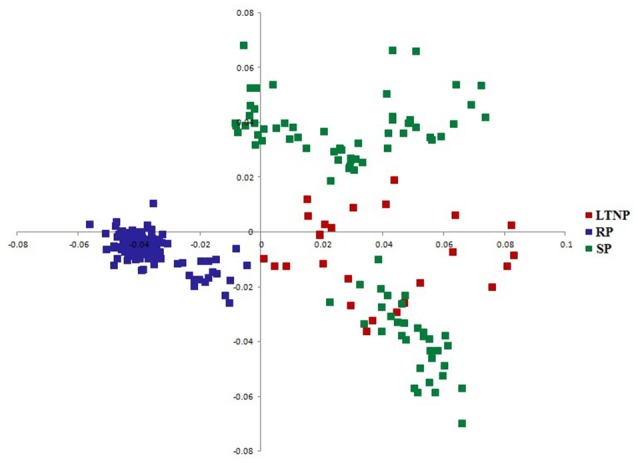
Distribution of env genes along the two major axes of correspondence analysis (COA) based on RAAU data. x-axis- Axis 1 of RAAU; y-axis- Axis 2 of RAAU. Red colored square boxes represent Long term non-progressor (LTNP) sequences. Blue colored square boxes depict Rapid progressor (RP) sequences. Green colored square boxes refer to Slow progressor (SP) sequences.